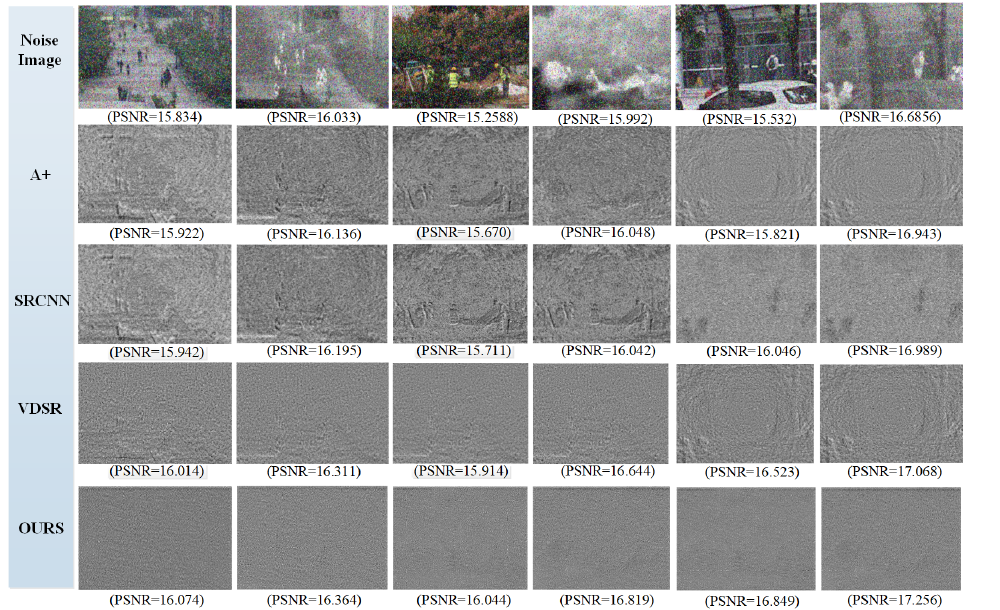
Figure 7. Difference image, which is A+, SRCNN, VDSR, ours SR result subtracting the input noise image. (PSNR values for noise image SR